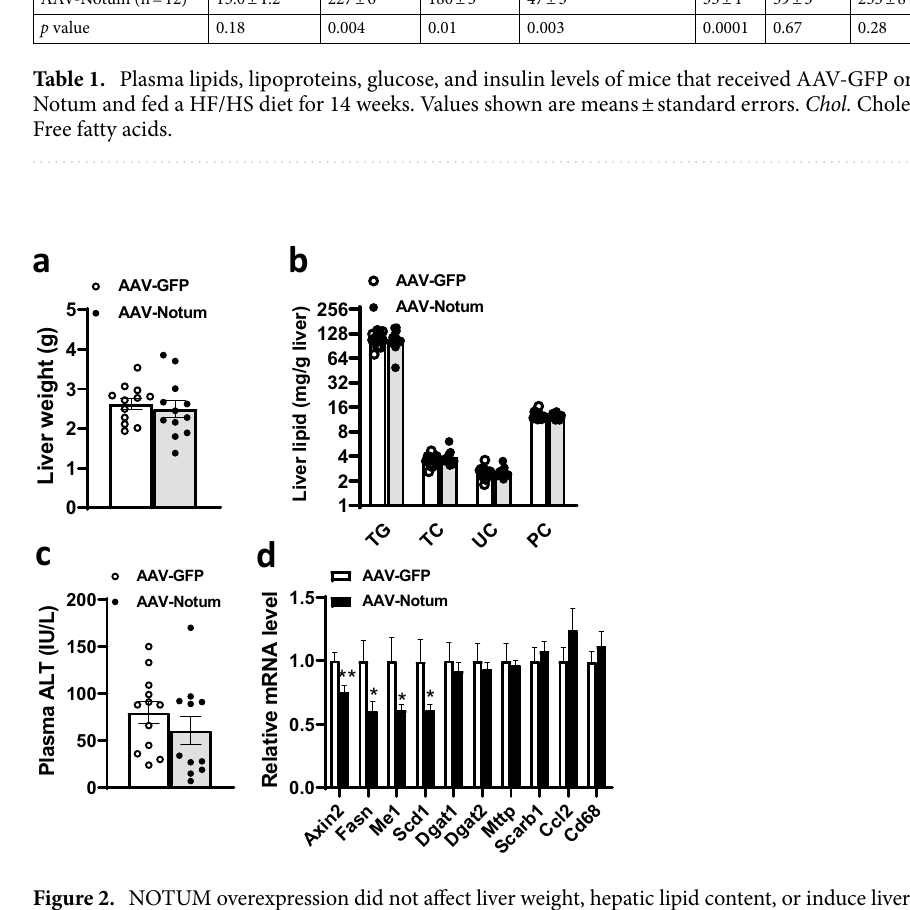
Figure 2. NOTUM overexpression did not affect liver weight, hepatic lipid content, or induce liver injury. Liver and plasma samples from mice described in Fig. 1a–j (n = 11–12 per group) were examined for ( a ) liver weight, ( b ) liver lipid content including triglyceride (TG), total cholesterol (TC), unesterified cholesterol (UC), and phosphatidylcholine (PC), ( c ) plasma ALT levels, and ( d ) liver gene expression by qPCR. Symbols are the same as Fig.